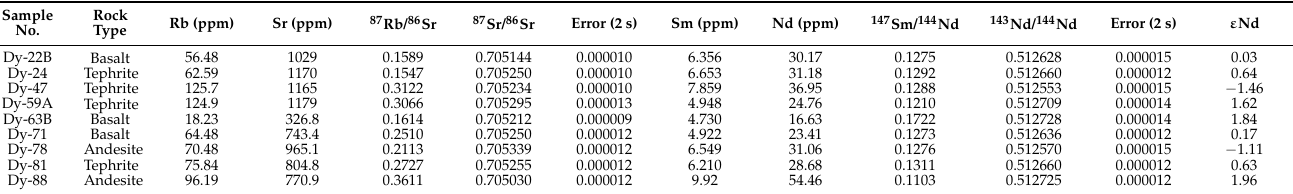
Table 2. Initial ratios for 87Sr/86Sr and 143Nd/144Nd of the dyke swarms.